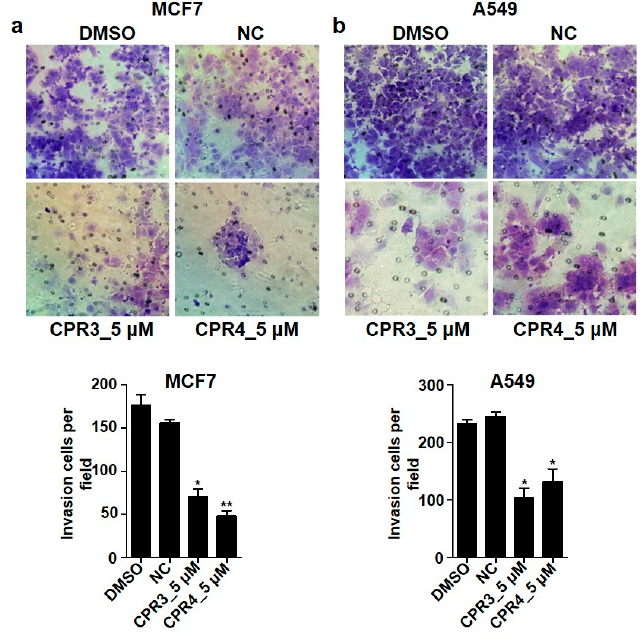
Figure 5. Invasiveness images of MCF7 ( a ) and A549 ( b ) cells treated with CPR3 or CPR4 for 24 h. The cells, resuspended in RPMI-1640 without serum, were reseeded on matrigel-coated insert transwell for 24 h. After 24 h, the cells that migrated to the membrane of the transwell were stained with 0.1% crystal violet and were counted with bright optical microscopy. * P ≤ 0.05 and ** P ≤ 0.01, as determined by Student’s t-test.